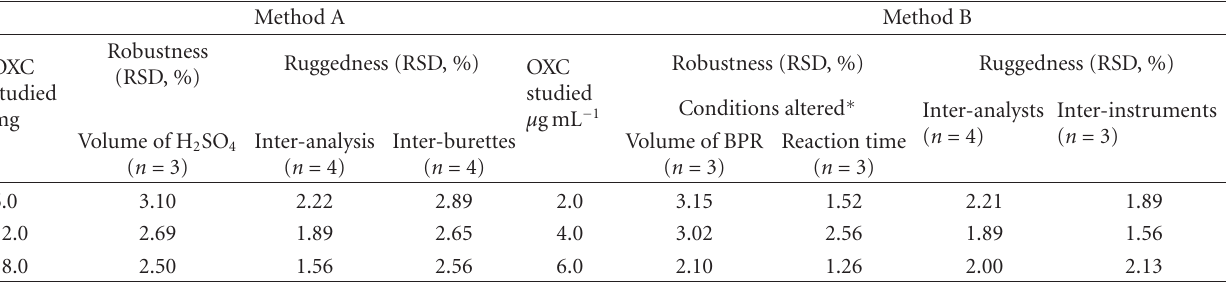
Table 3: Robustness and ruggedness.